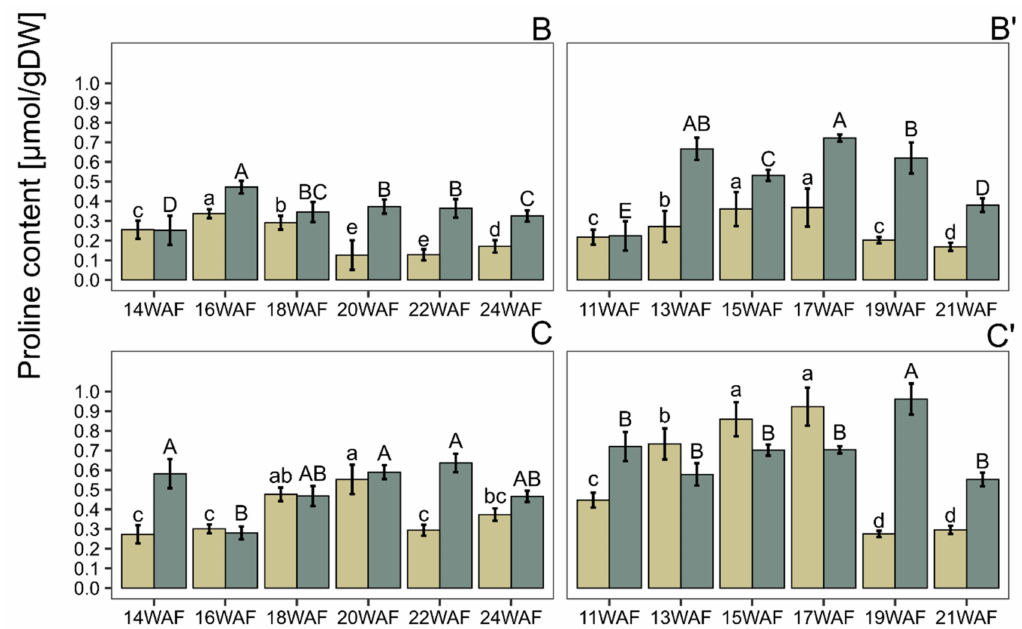
Figure 3. Proline content in subsequent weeks after flowering (WAF) in embryonic axes and cotyledons in Norway maple seeds collected in 2017 ( A ), 2018 ( B ), and ( C ) 2019, and sycamore seeds collected in 2017 ( A’ ), 2018 ( B’ ), and 2019 ( C’ ). Results represent the means of three samples ± SD. Means